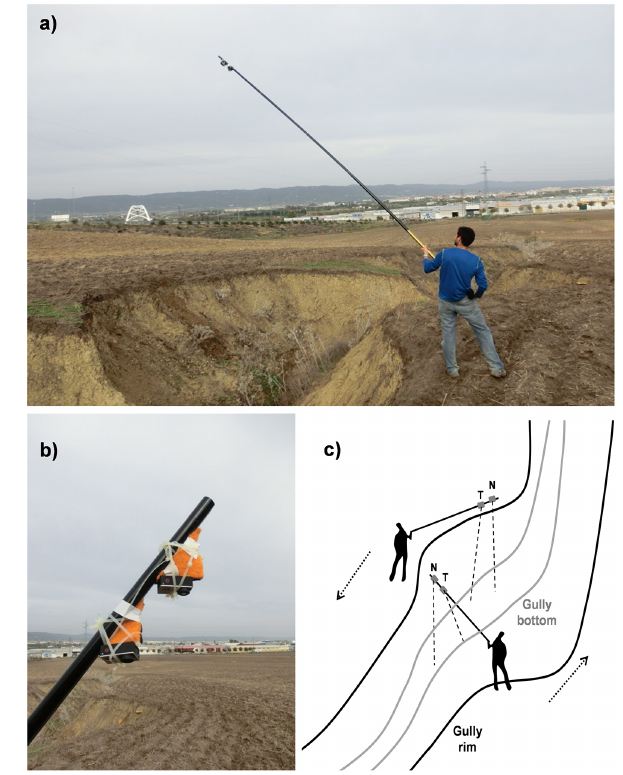
Figure 3. Camera operation in the gully erosion study: (a) view of the operator during the field survey; (b) closer view of the two GoPro Hero3 + cameras on the 6m pole with differential angle be- tween cameras. (c) Sketch of the image collection methodology as a walking itinerary along the gully perimeter. The rough nadir per- spective (N) corresponds to the camera close to the pole tip and the tilted perspective (T) to the camera slightly